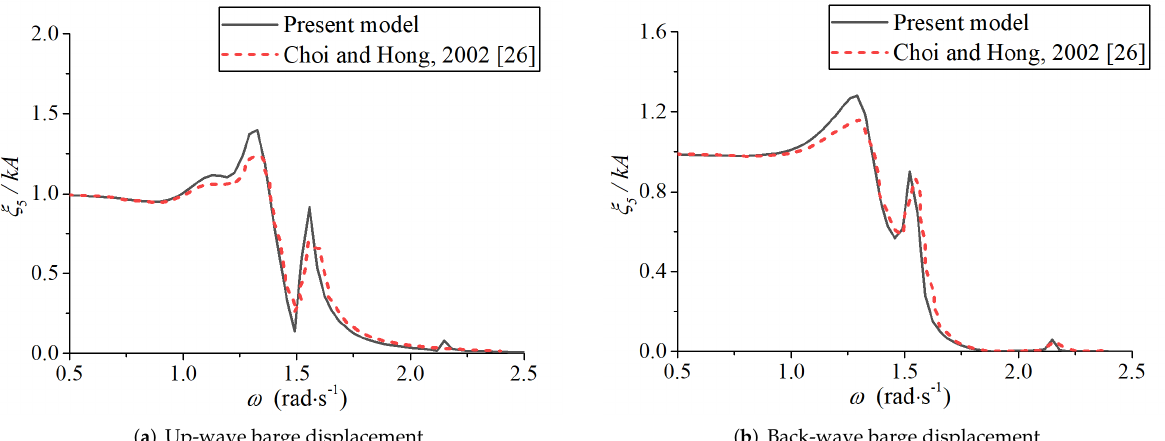
Figure 5. Displacement of barges in the surge direction: ( a ) up-wave barge; ( b ) back-wave barge